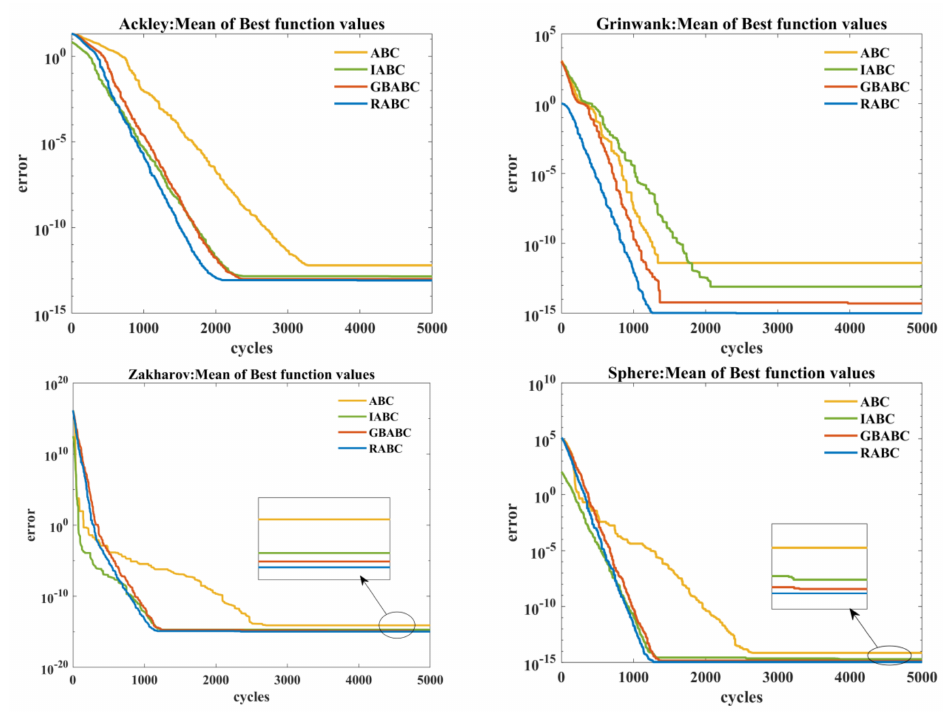
Figure 4. Convergence obtained by the ABC, IABC, GBABC, and RABC algorithms. Figure 5 shows a boxplot of iterative data for four algorithms. The top and bottom edges of the boxplot indicate the 75th percentile and 25th percentile, respectively. From Figure 5, it can be further seen that the top and bottom edges of the boxplot from the RABC almost overlap, which further illustrates the fast convergence of the RABC.